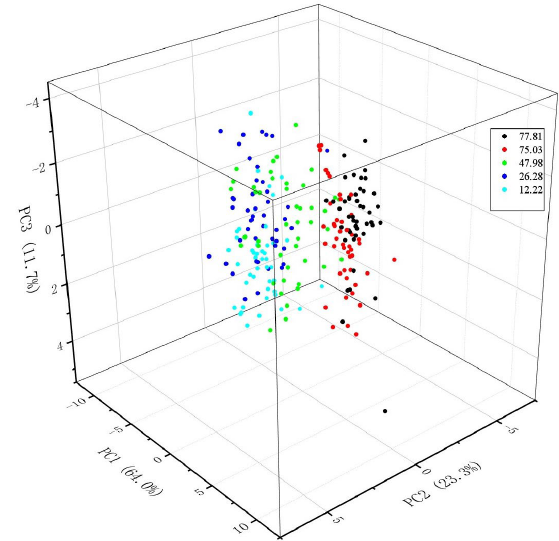
Figure 6. Three-dimensional (3D) load distribution map obtained from the results of PCA analysis conducted for colorimetric and gloss during tea processing.